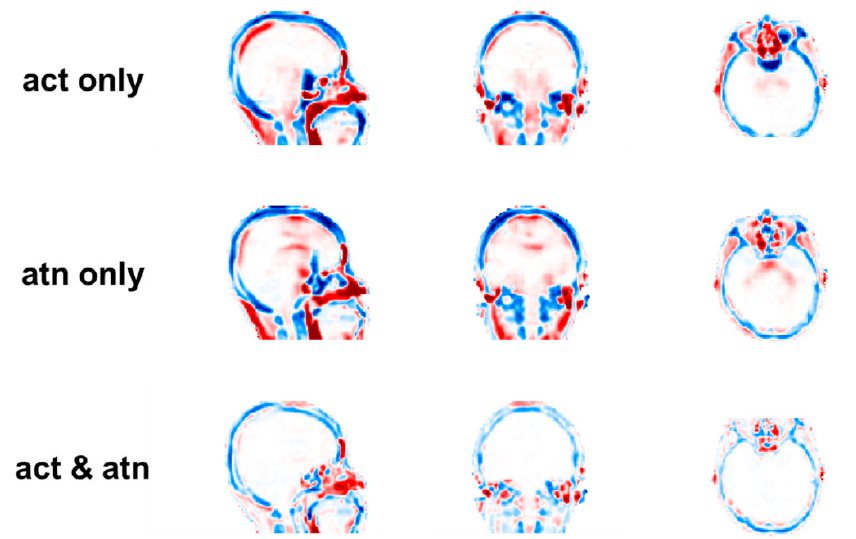
Figure 7. Relative importance of λ -MLAA and µ -MLAA input. Combined input ( λ -MLAA and µ -MLAA) yielded the smallest error, and the amount of error in the networks trained using only λ -MLAA and µ -MLAA was almost identical.